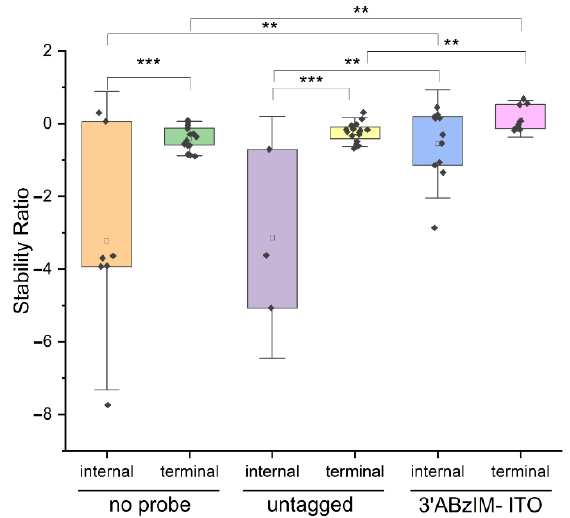
Figure 6. Comparison of stability ratios for nuclease protection assays involving 15-mer RNA standards with either a 5 ′ terminal or an internal GGACU motif. Assays were conducted without a probe, with an un-tagged probe, or with the ABzIM-ITO. Within each box plot (25th to 75th percentile), the small square represents the mean of the data. Individual data points are represented by black diamonds. Error bars are 1.5 SD, unpaired t -test, ** p < 0.01, *** p < 0.001.